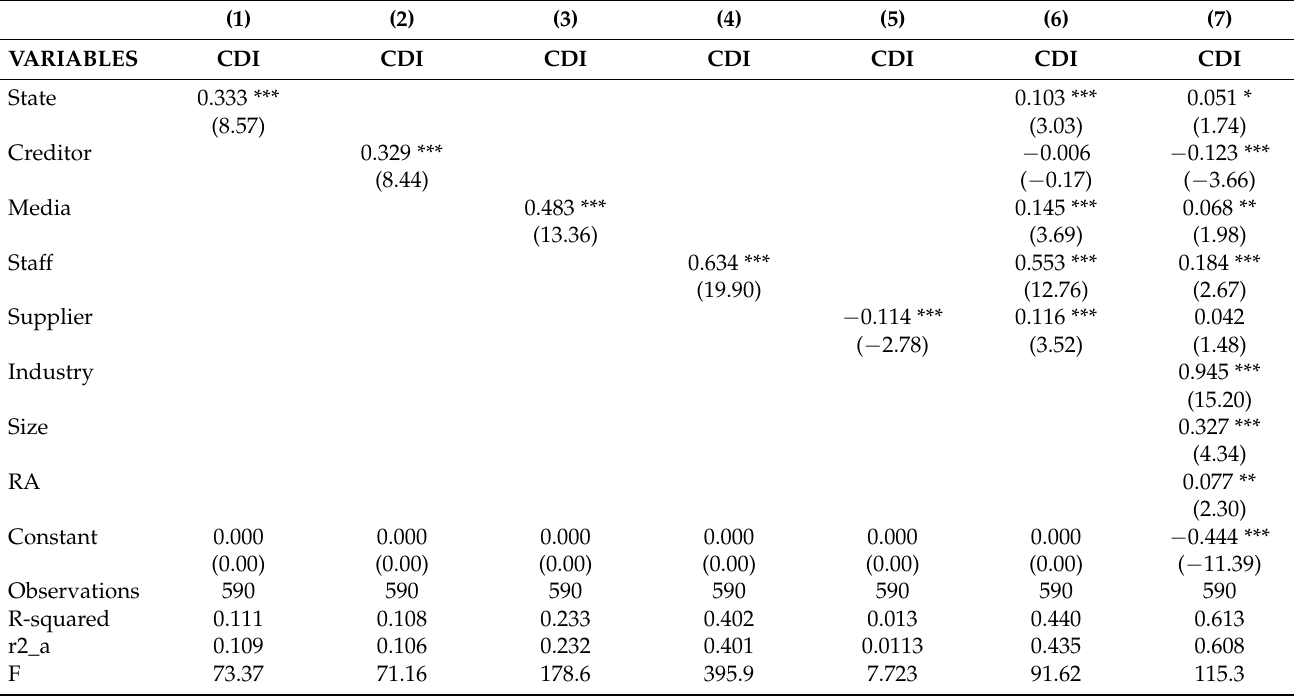
Table 6. Multiple regression